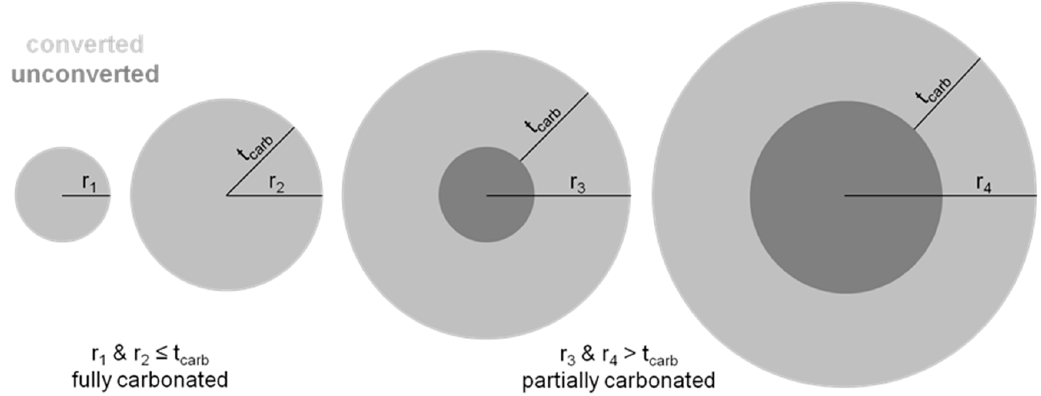
Figure 7. Theoretical model of physical carbonation conversion extent for particles of different size (see text for the description of the assumptions made) [39].